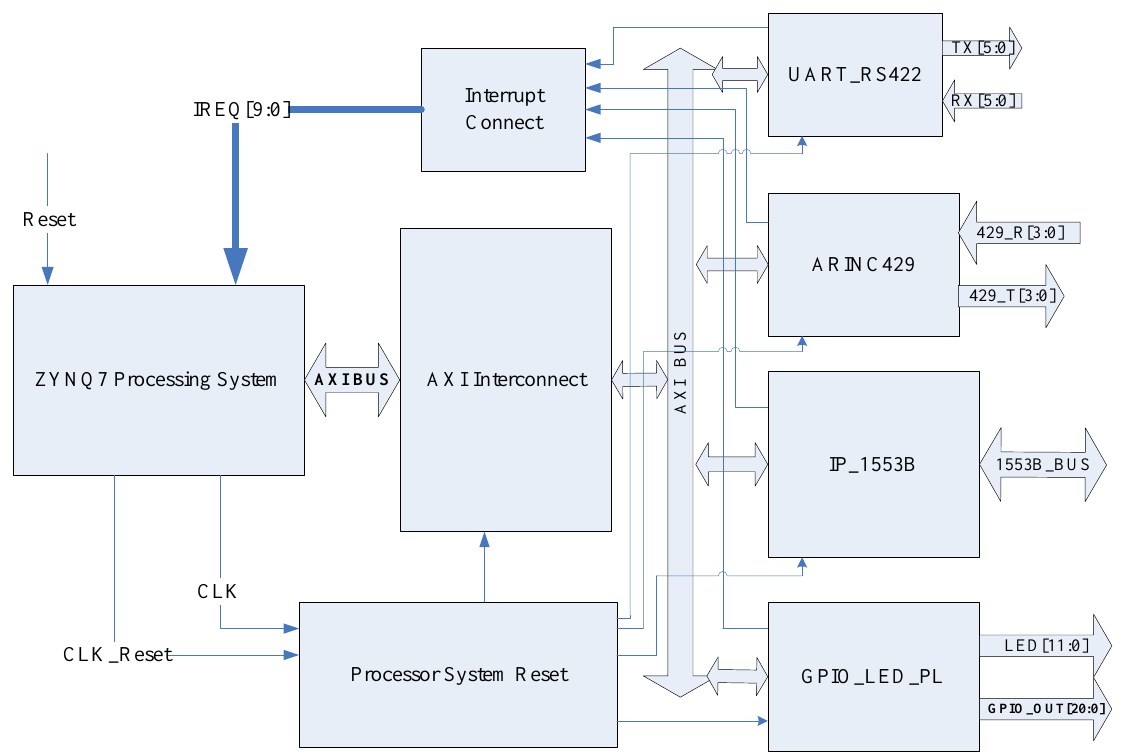
Figure 6. Zynq SoC internal construction diagram.